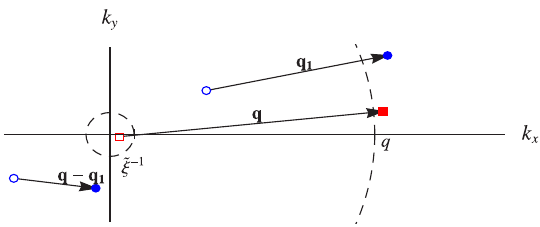
FIG. 2. High-momentum excitations that determine the deep inelastic form of the dynamic structure factor (in a 2D plane) at ~ ξ − 1 ~ ξ large momentum transfer q ≫ , where is the characteristic length scale which sets the typical wave vector of the atoms. We consider two cases. First, a single atom with wave number k (empty red square) can be transferred to a state with large wave vector k þ q (red filled square). Second, two initial atoms ð k 0 ; − k 0 Þ with large and opposite momenta (blue circles) can be excited to high momenta ð k 0 þ q 1 ; − k 0 þ q − q 1 Þ (blue dots). Energy conservation implies for the probe energy in the first case ℏ ω − ε O ð q 1 Þ — the quasifree regime — and in the second q ¼ case ℏ ω − ε q ¼ O ð q 2 Þ — the multiparticle